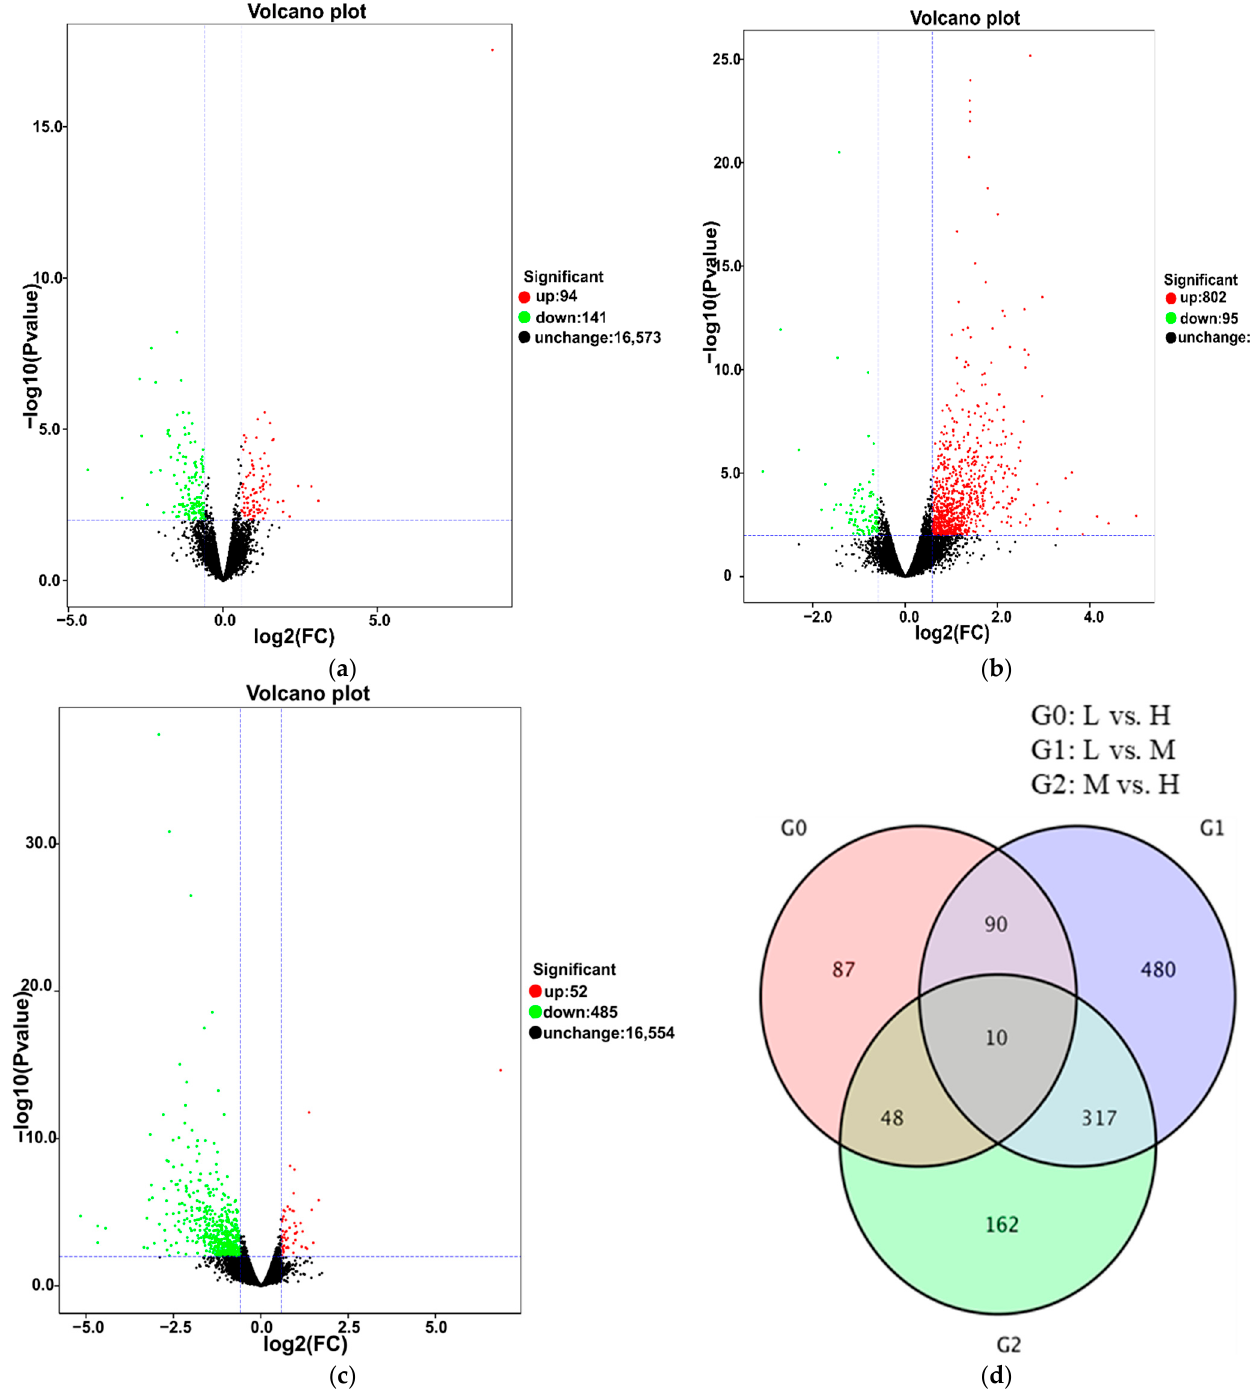
Figure 3. Differential expression volcano map of L vs. H, L vs. M, and M vs. H at E-L 35 stage, respectively ( a – c ). Venn diagram depicting the shared and unique differentially expressed genes (DEGs) identified by RNA-Seq analysis between grapes at the E-L 35 stage ( d ). Each point in the differential expression volcano map represents a gene, and the abscissa represents the logarithm of the multiple of the differential expression of a gene in the two samples. The ordinate represents the negative logarithm of statistically significant changes in gene expression. The green dots represent downregulated differentially expressed genes, the red dots upregulated differentially expressed genes, and the black dots non-differentially expressed genes.